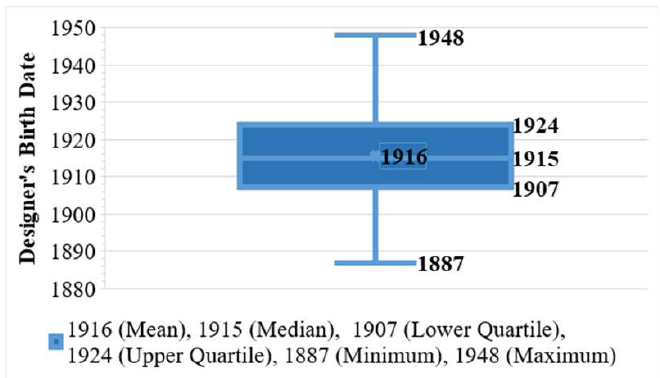
Figure 2. Birth dates of designers.